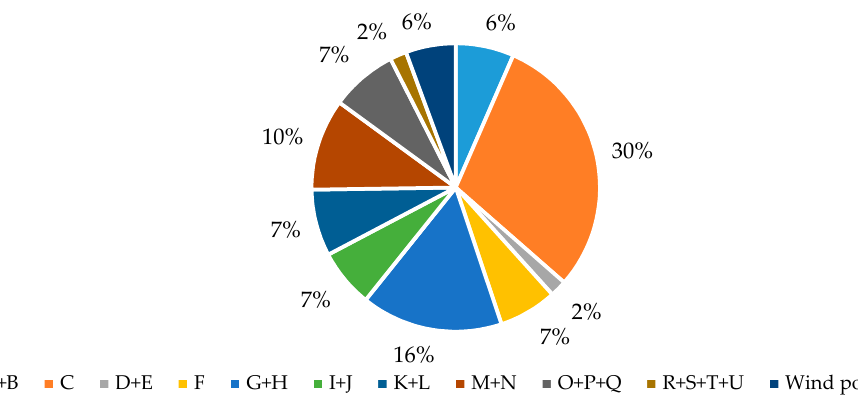
Figure 5. Intermediate consumption channel during regular operation of plants, the structure of total GVA effects per sectors.